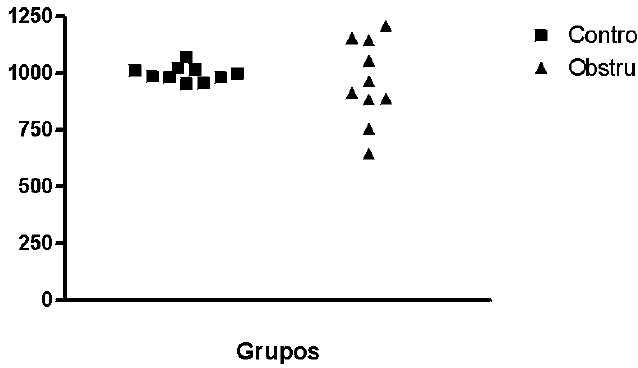
Figura 2 - Dosagem de hidroxiprolina, onde se evidencia variância significativa no grupo